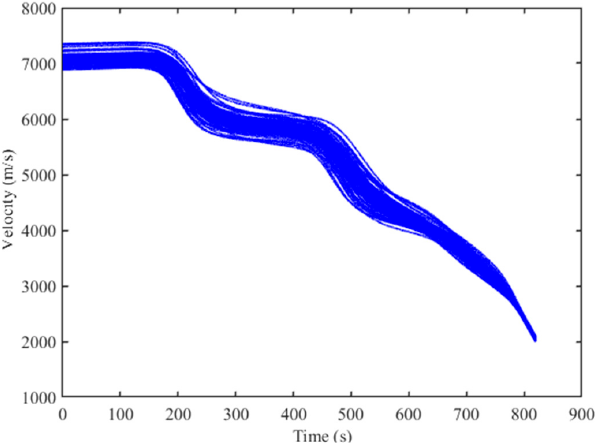
Figure 27. Time histories of the velocity.